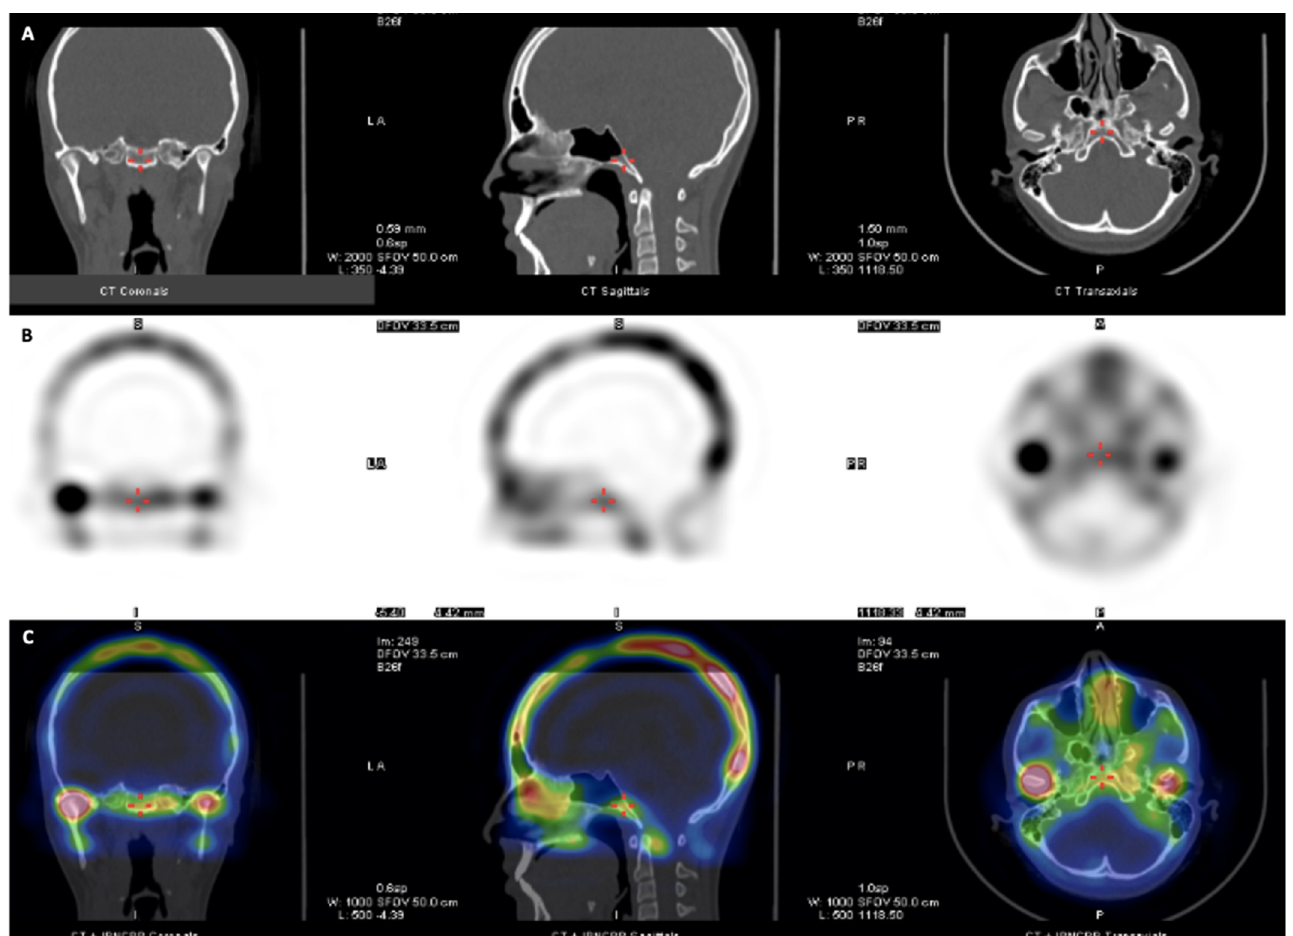
Figure 1. ( A ) Computed tomography (CT) images: coronal, sagittal, and axial sections. ( B ) Single photon emission CT (SPECT) images: coronal, sagittal, and axial sections. ( C ) Fused functional images (SPECT and CT) in a patient with right side active unilateral condylar hyperplasia (UCH).